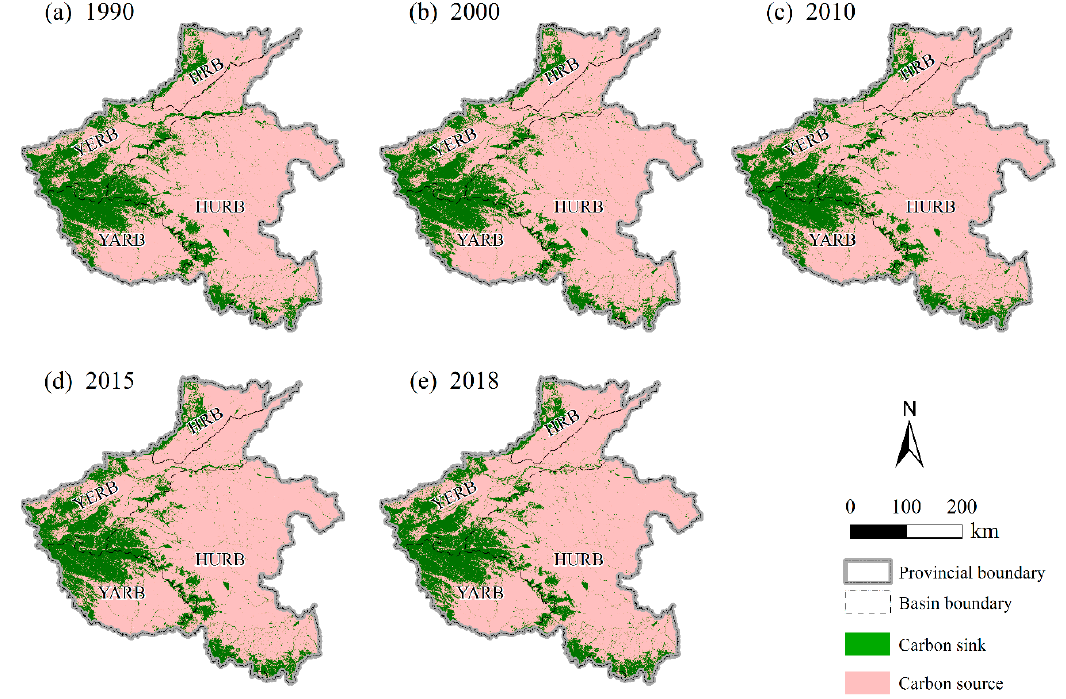
Figure 6. Spatial distribution of carbon sinks and carbon sources in the study area in 1990, 2000, 2010, 2015, and 2018.